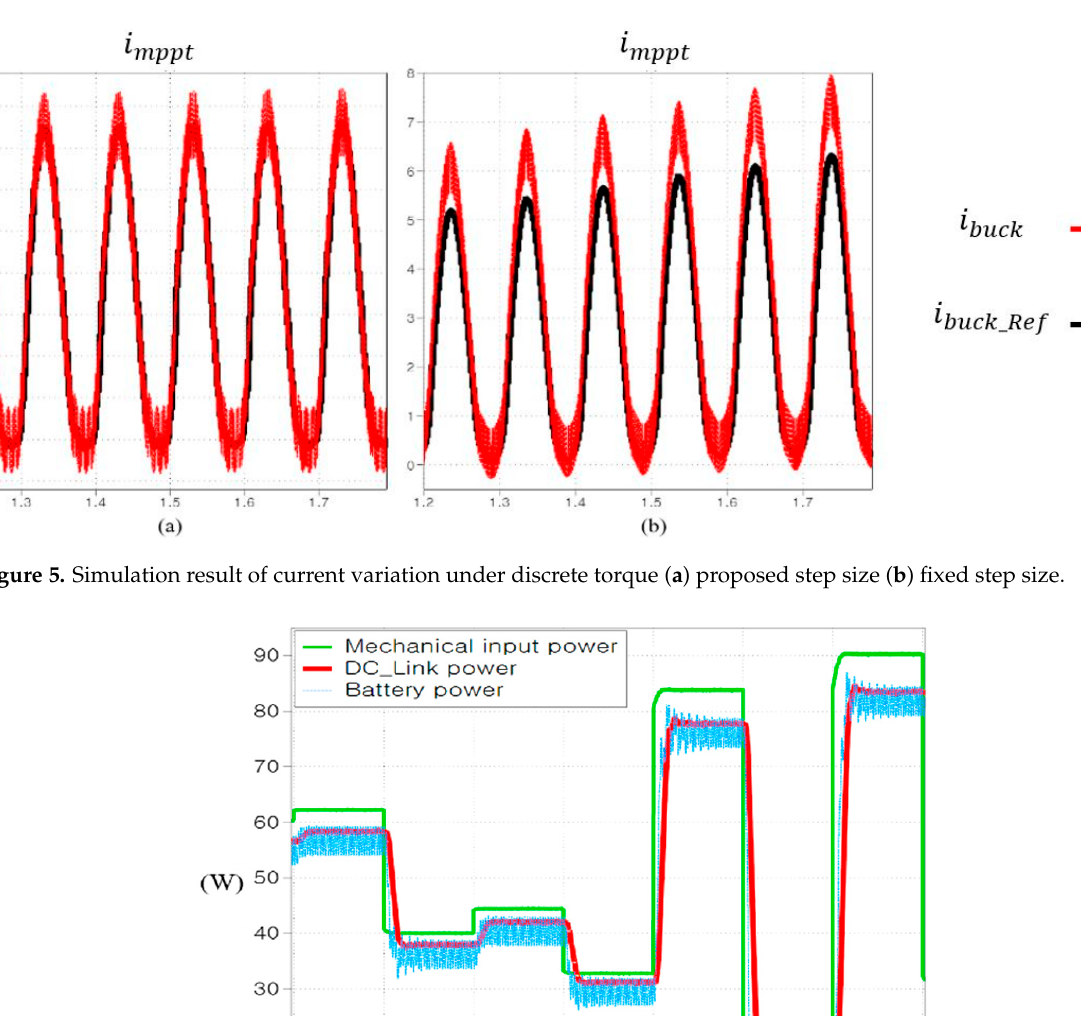
Energies 2021 , 14 , x FOR PEER REVIEW